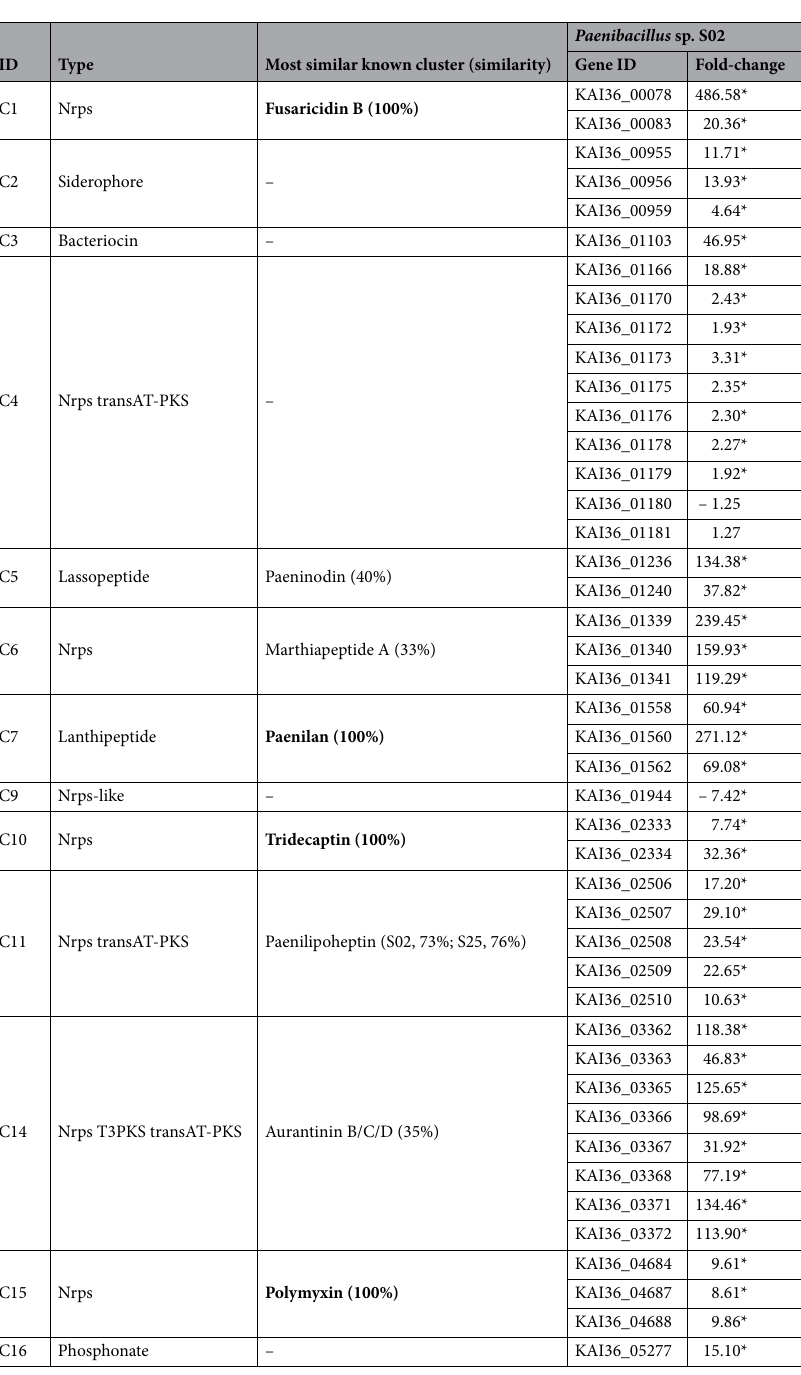
Table 3. Fold-changes in expression levels of the core biosynthetic genes of secondary metabolite gene clusters of strain S02 compared to strain S25 when F. verticillioides was absent. Clusters in bold: Known antimicrobial compounds. *Genes that were differentially expressed ( q-value < 0.05 and absolute fold-change ≥ 1.5) when comparing the two